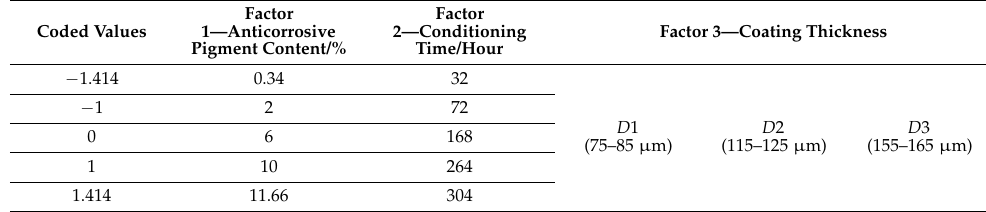
Table 1. Coded values for the experiment plan. Coded